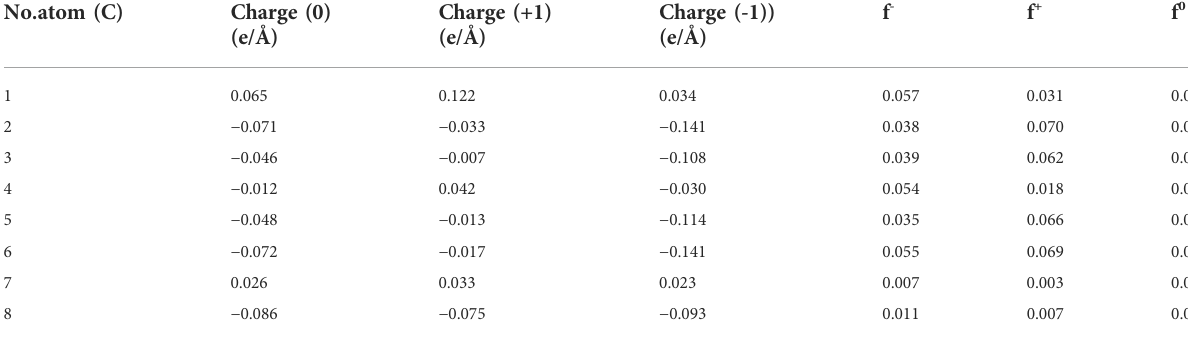
TABLE 2 Hirsh fi eld charge distribution and Fukui function of